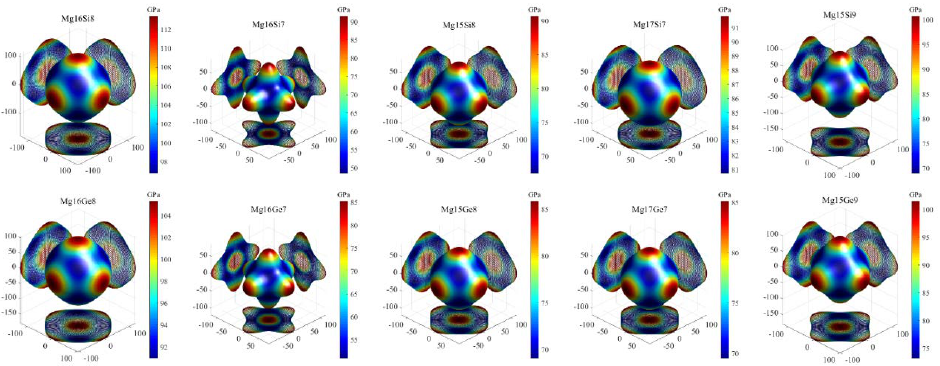
(GPa) of Mg 2 X (X=Si, Ge) Intermetallics in the 1×1×2 𝐸𝐸